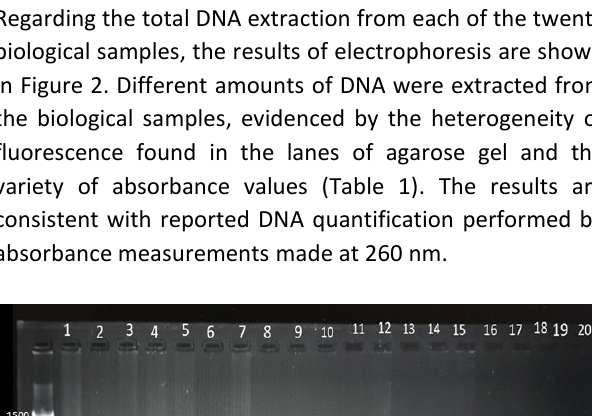
and phase (Figure 3). The reference (blank) and miliQ (mQ) EBiS measurements, respectively, and their spectra